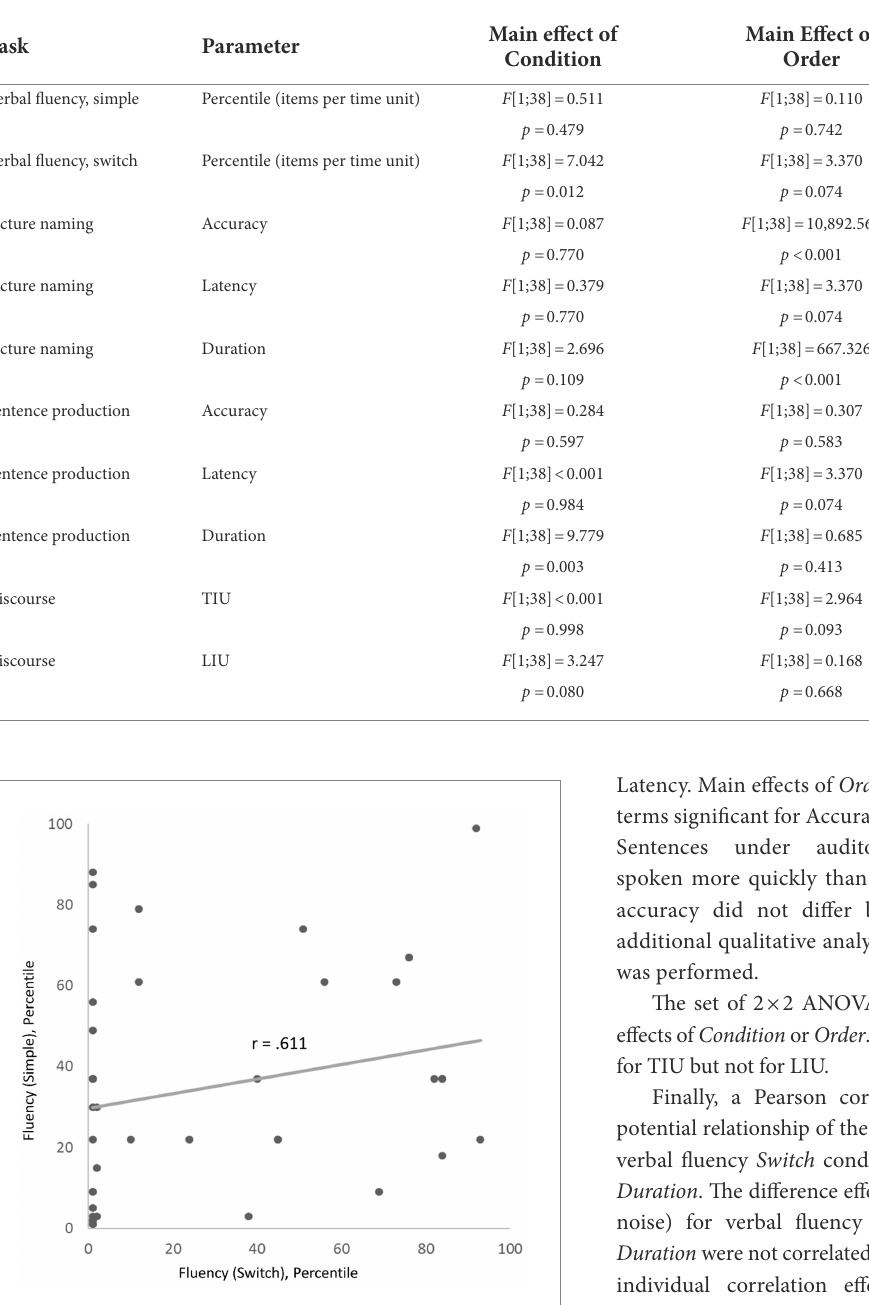
TABLE 1 Results of the 2 × 2 ANOVAs for effects of Condition and Order and their interaction.